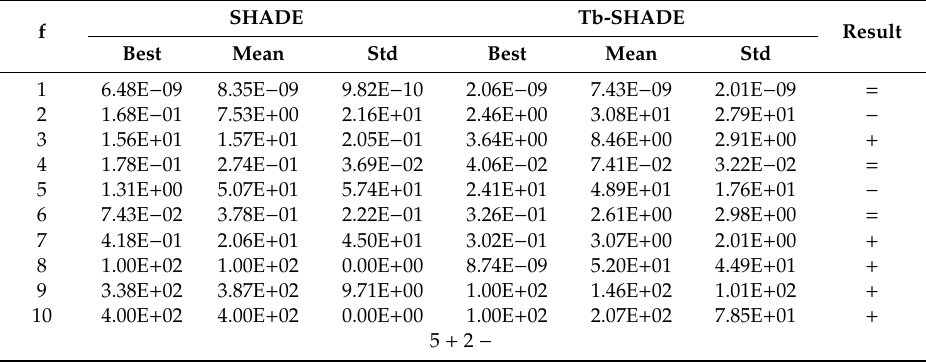
Table 9. SHADE vs. Tb-SHADE on CEC2020 in 15 D .